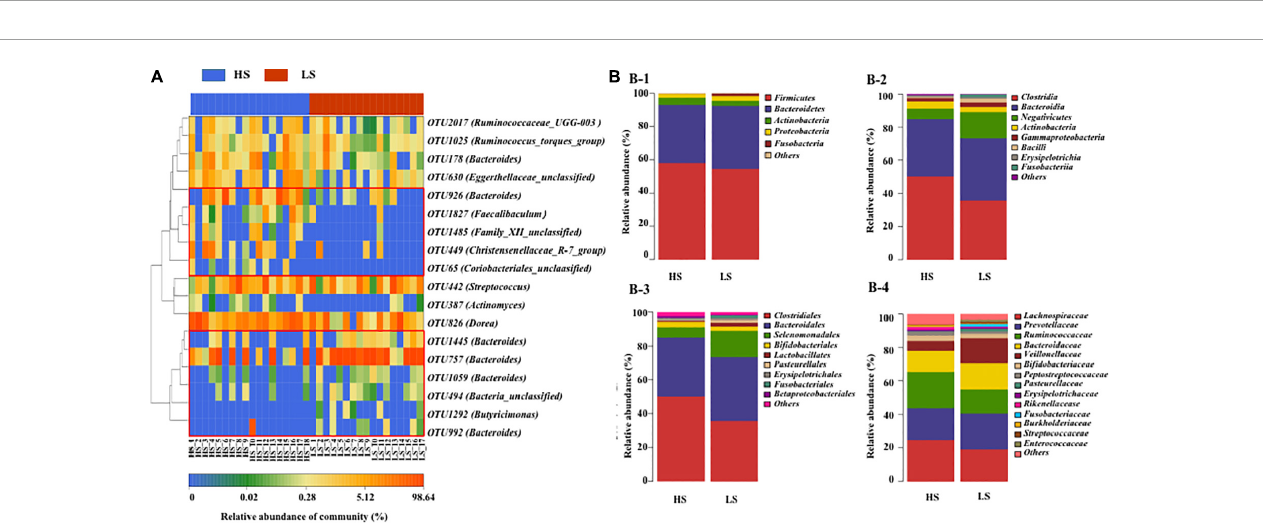
FIGURE3 Heat map of relative abundance at the level of OTU (A) and composition (B) of the fecal microbiota at the level of (B-1) phylum, (B-2) class, (B-3) order, and (B-4) family in HS and LS groups. HS, the high-status NCPB; LS, the low-status